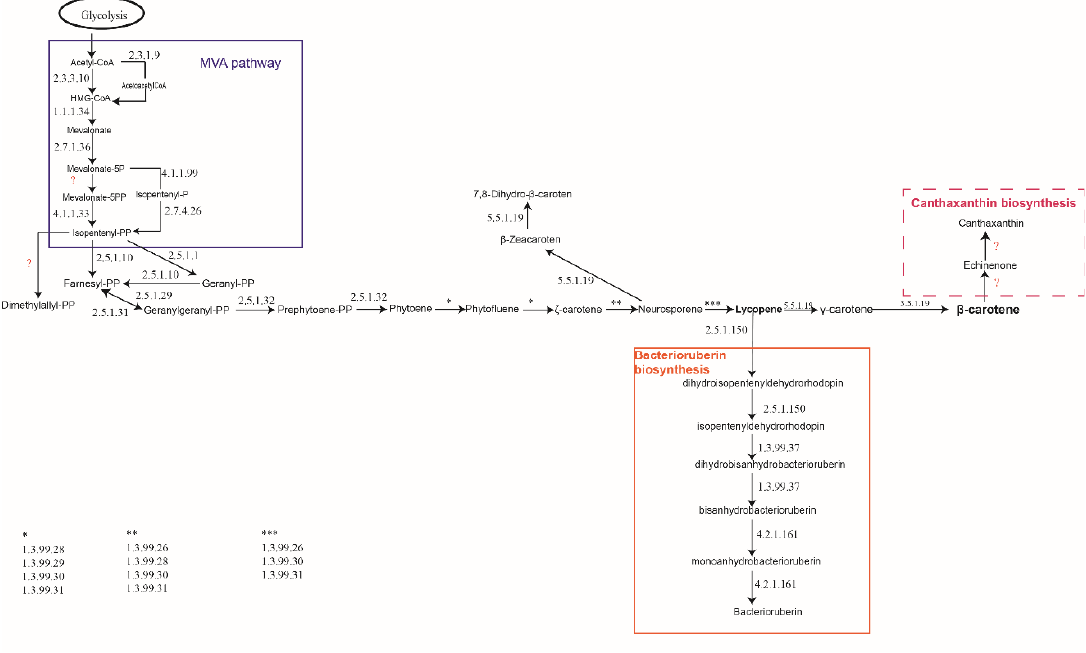
Figure 2. Carotenogenesis predicted in haloarchaea based on in silico analysis.